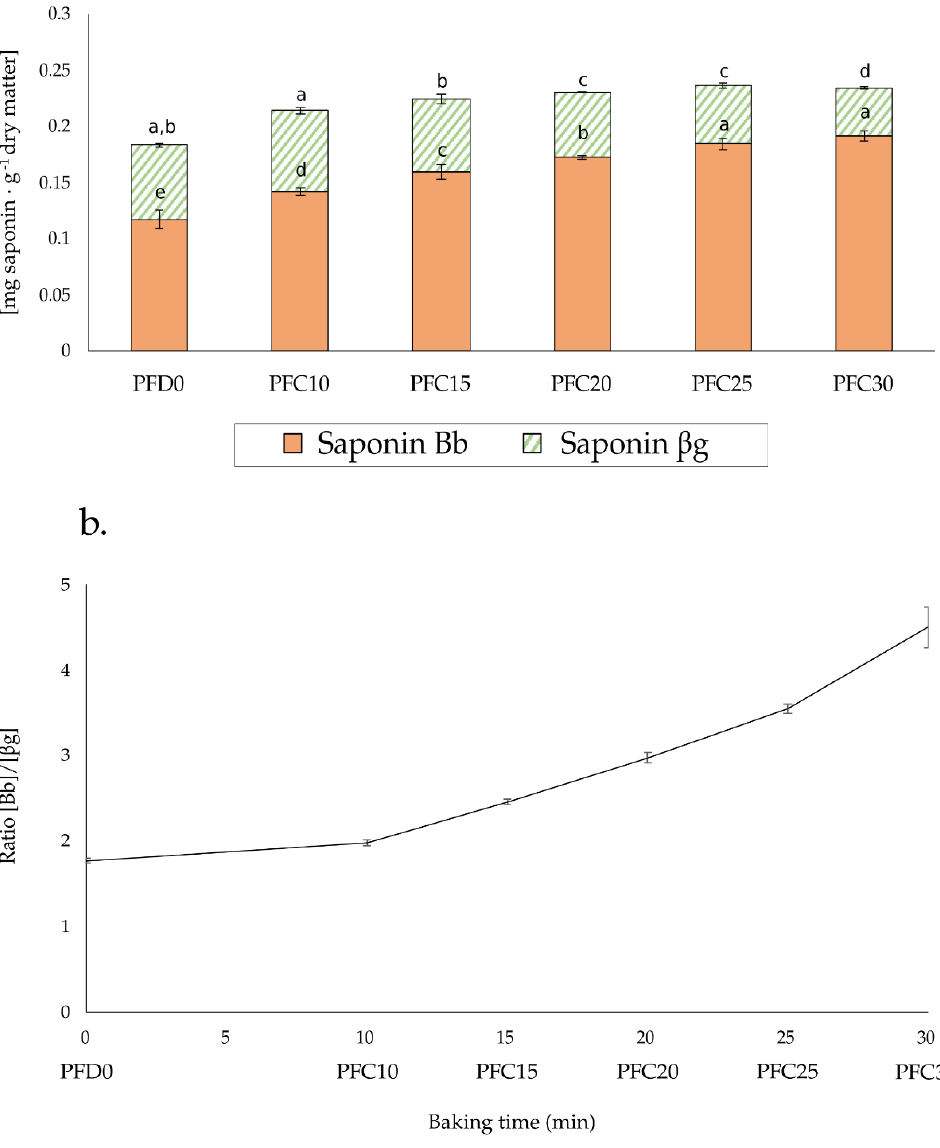
Figure 3. Saponins measured in the dough and in cakes baked at five different baking times. ( a ) Concentrations [mg · g − 1 dry matter] of saponin β g (in striped green) and Bb (in orange) in PFC as a function of baking time. Different letters at the top of each color bar represent significantly different means with respect to each saponin type across samples ( p < 0.05). PFD0 = pea flour unbaked dough, PFC10 = pea flour cake baked for 10 min, PFC15 = pea flour cake baked for 15 min, PFC20 = pea flour cake baked for 20 min, PFC25 = pea flour cake baked for 25 min, and PFC30 = pea flour cake baked for 30 min. ( b ) Bb: β g ratio plotted versus baking times (min). The corresponding cakes are also specified on the